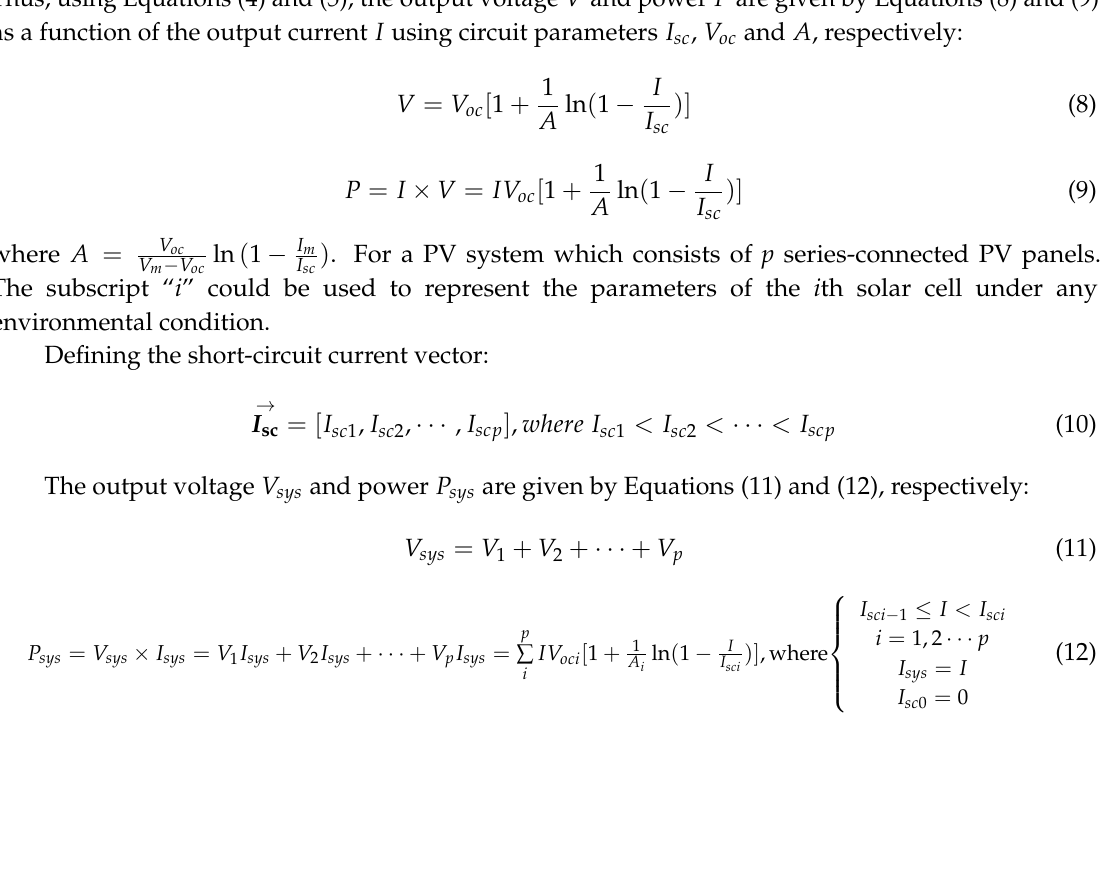
Figure 2. Array of 2 PV array connected in series; ( a ) (cid:1835) > (cid:1835) (cid:3046)(cid:3030)(cid:2869) and ( b ) (cid:1835) < (cid:1835) (cid:3046)(cid:3030)(cid:2869) .